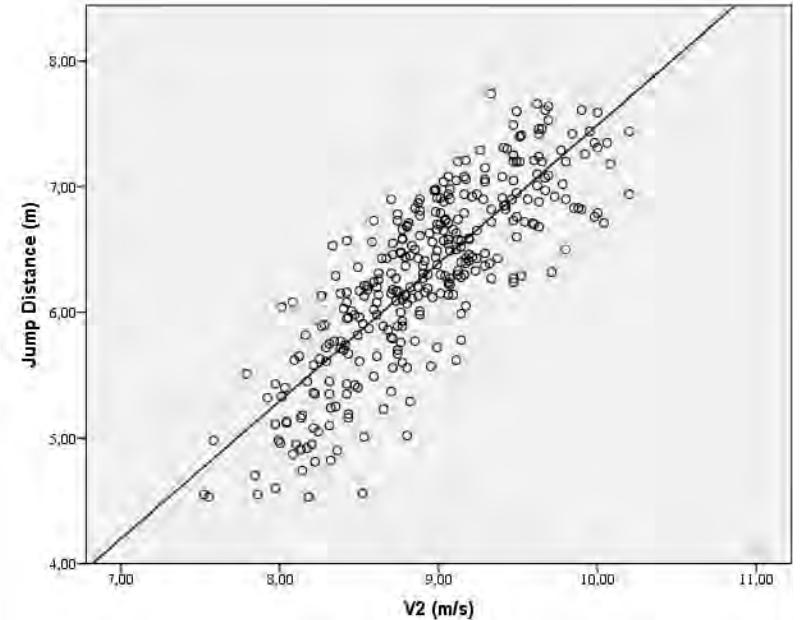
Figure 3. The relationship between the approach run-up velocity which is V2 (6-1 m) and official jump distance (r=0.82, p<0.05; r 2 =0.68)